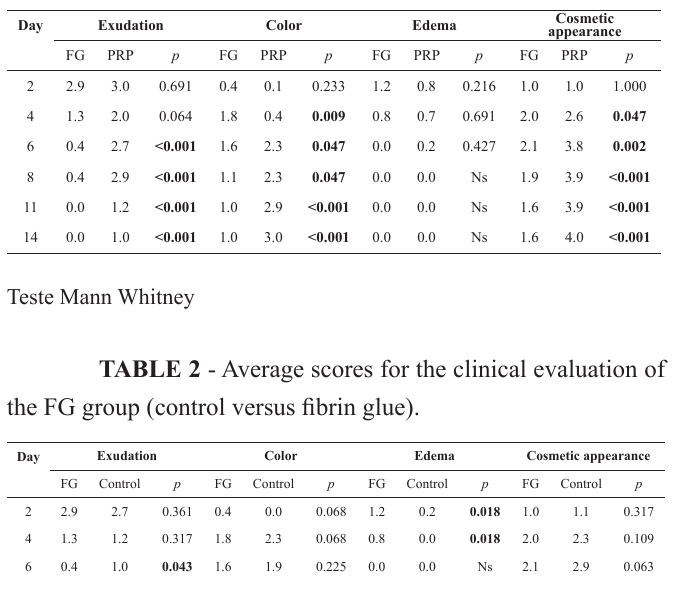
TABLE 1 - Average scores for the clinical evaluation of the FG group compared with PRP.